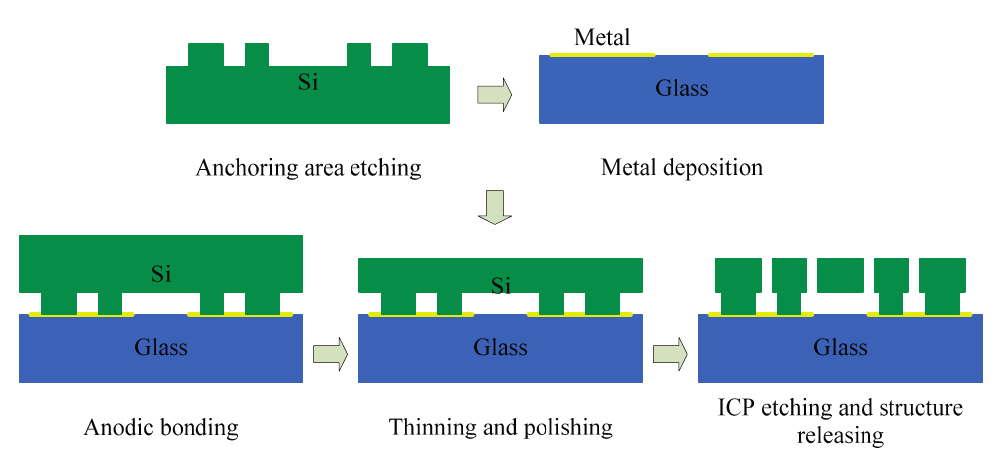
Figure 7. Fabrication process of DDSOG (Deep Dry Silicon on